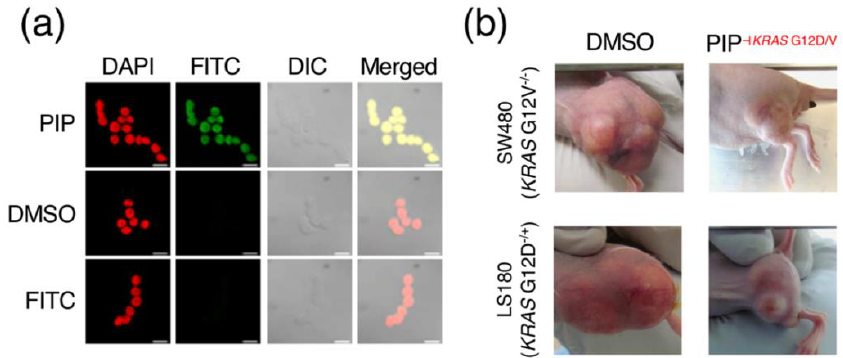
Figure 2. Biological applications of PIPs. ( a ) Example of in-situ cell imaging using a fluorescein isothiocyanate (FITC)-conjugated PIP; reproduced from [22], © 2018 with permission from Elsevier.